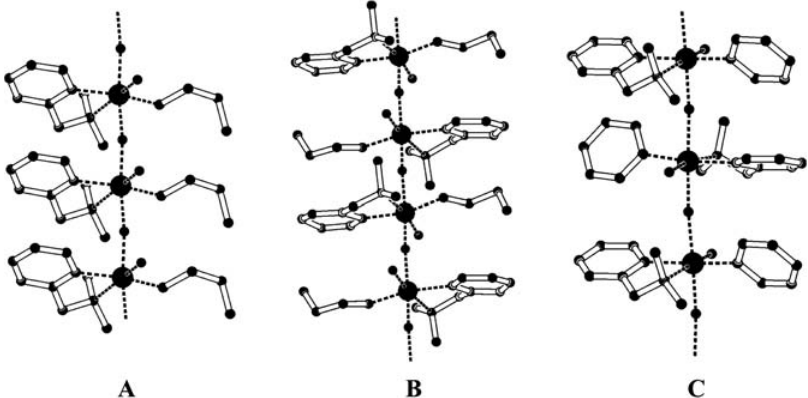
Figure 6 Comparative view of isotactic [L CN ( n -Bu)SnF